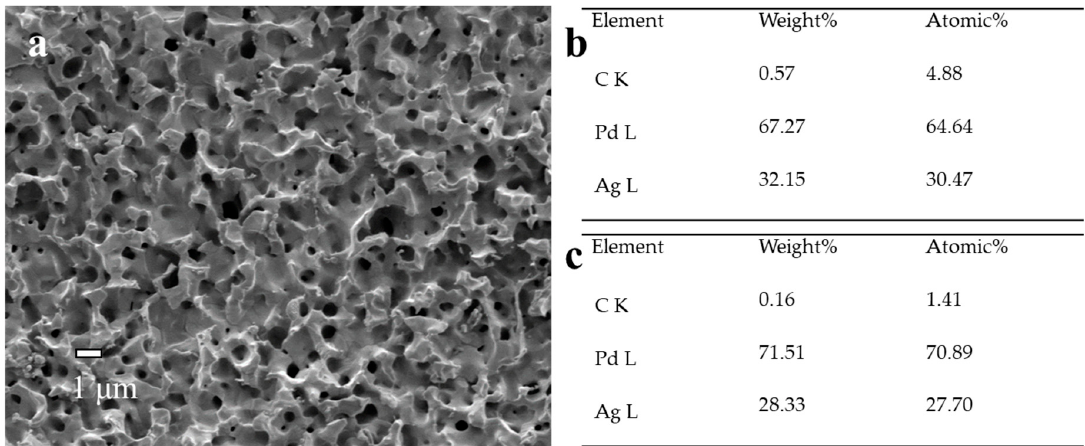
Figure 10. ( a ) SEM image, ( b ) surface EDS analysis and ( c ) cross-sectional EDS analysis of PA-1 after repair.